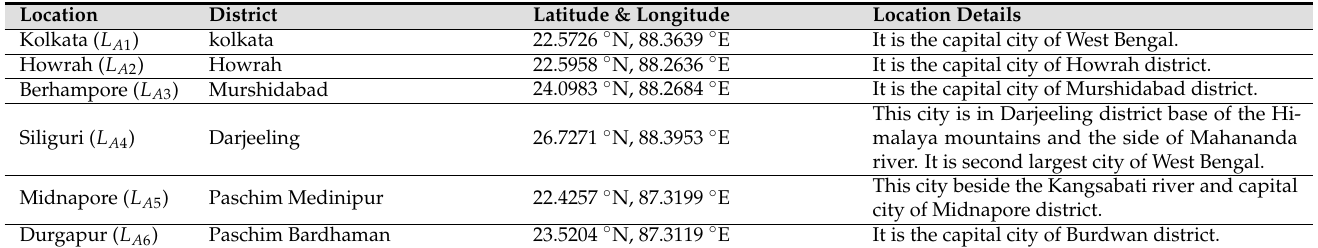
Table 8. Used location (alternative) details.